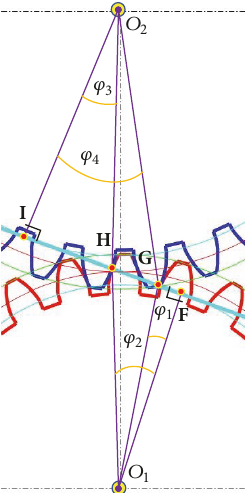
Figure 21: Contact geometry for frictional moment analysis